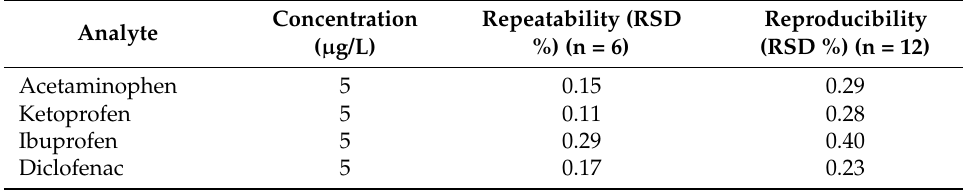
Table 6. Precision data obtained on real